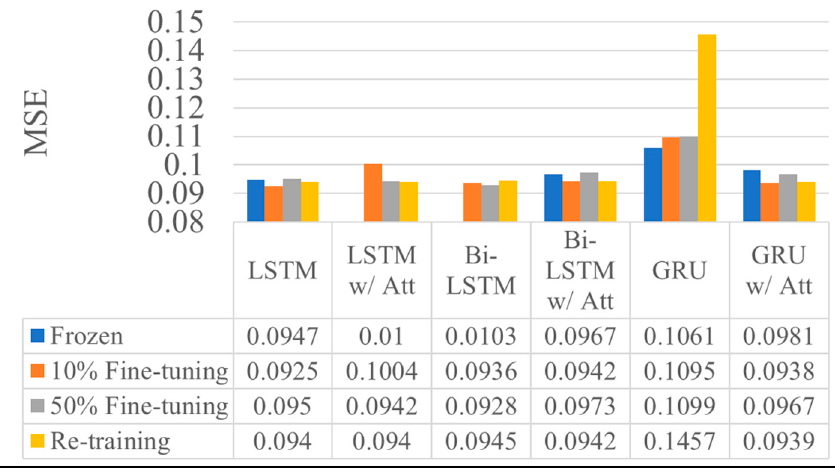
Figure 11. MSE of the source disease course prediction of TL-CDC under k = 4.